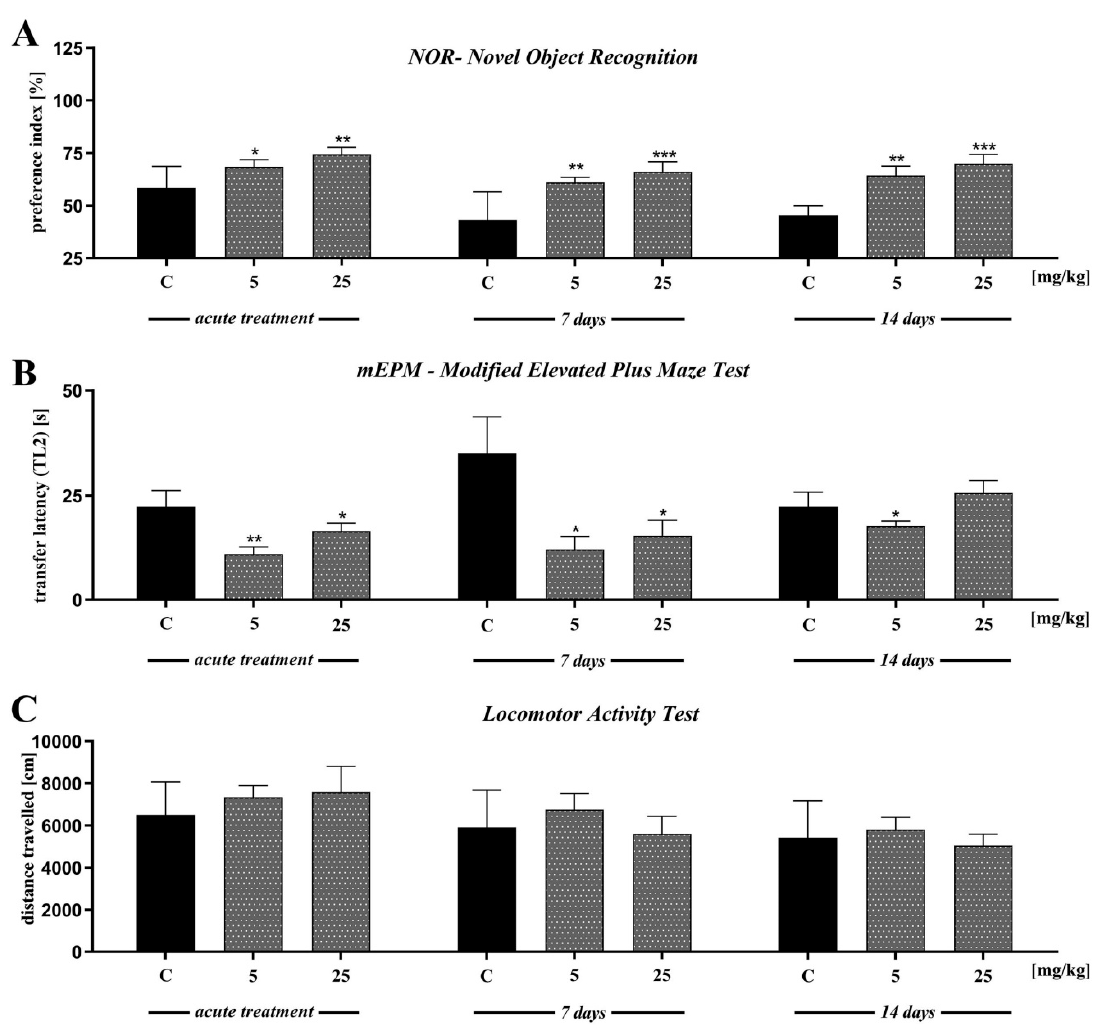
Figure 6. The effect of D2AAK1 on learning and memory processes ( A , B ) and locomotor activity ( C ). Mice were treated with two different doses of D2AAK1 for a different time period and NOR, mEPM, locomotor activity tests were performed. Bars indicate S.E.M, n = 8–10, * p < 0.05; ** p < 0.01; *** p < 0.001.